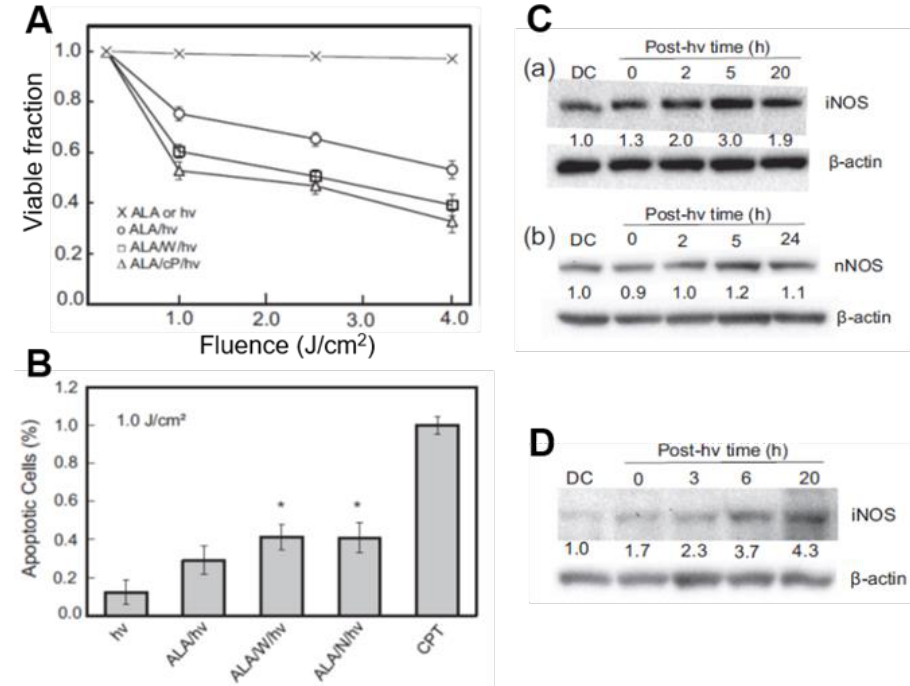
Figure 2. Upregulation of iNOS/NO in photodynamically-stressed glioblastoma cells confers resistance to photokilling. U87 or U251 cells at ~60% confluency were dark-incubated with 1 mM ALA for 30 min in serum-free medium, irradiated with broad-band visible light, then switched to serum-containing medium and dark-incubated for various periods. Where indicated, 25 µ M 1400W (W) or cPTIO (cP) was introduced immediately after irradiation and kept at the same concentration throughout. ( A ) MTT- assessed U87 viability 20 h after ALA/hν exposure in absence vs. presence of W or cP; n = 3. ( B ) Annexin V-FITC-assessed U87 apoptosis 4 h after indicated treatments (CPT: camptothecin); n = 3, * p < 0.05 vs. ALA/hν. ( C ) Immunoblot of U87 iNOS (a) and nNOS (b) at indicated post- hν times. Numbers below NOS bands indicate intensity relative to actin a nd normalized to dark (ALA-alone) control (DC). ( D ) Immunoblot of iNOS in U251 cells at indicated post- hν times. Adapted from Reference [32].